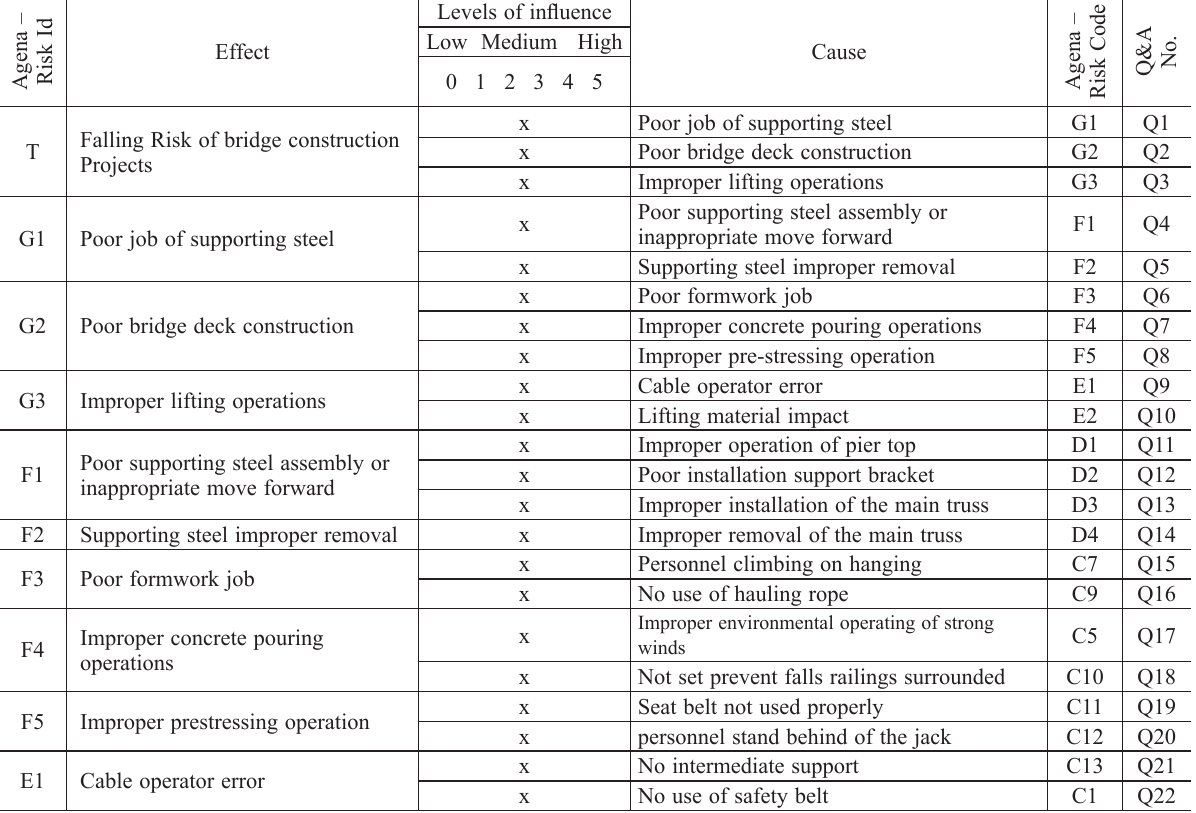
Table 3. Questionnaire example of relative weights of BN